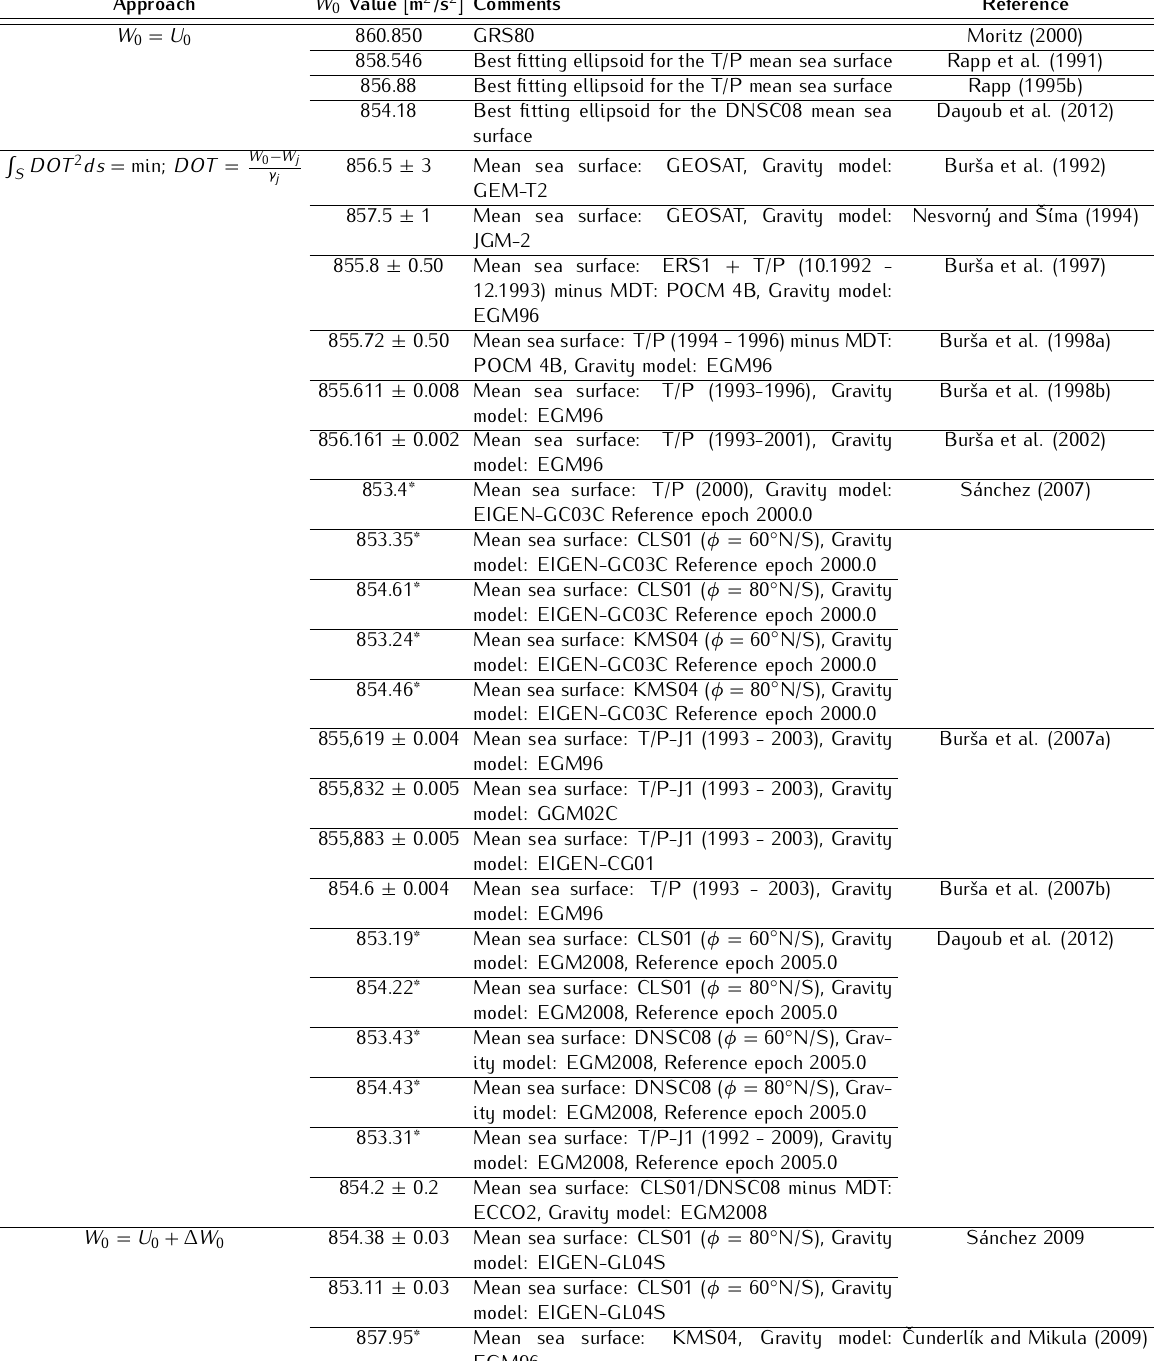
Table 3. Examples of current W 0 estimations (value 62 636 000 [m 2 /s 2 ] has to be